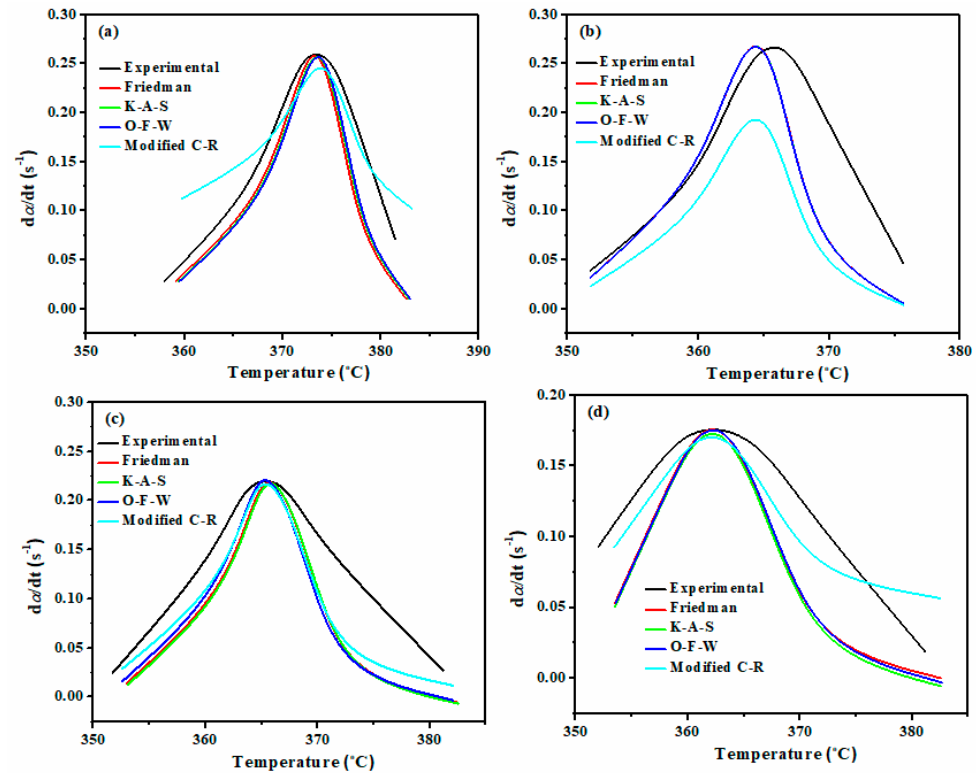
Figure 7. Predicted kinetics plots based on the Sestak Berggren decomposition reaction model for blank PU and its nanocomposites containing various nano-clay loadings at the heating rate of 5 °C/min, ( a ) blank PU, ( b ) PU/Nanoclay-1, ( c ) PU/Nanoclay-3, and ( d ) PU/Nanoclay-5.